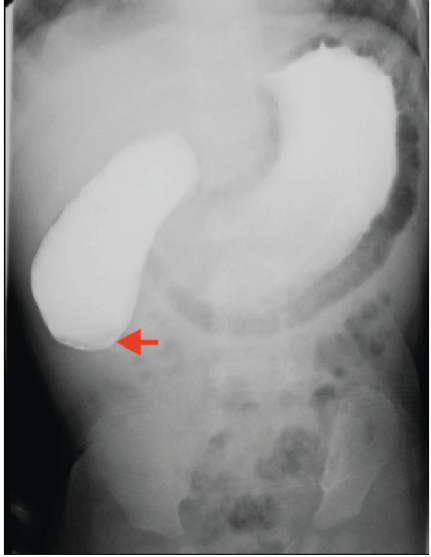
Figure 2: Upper gastrointestinal contrast study revealing complete obstruction at the 2nd part of the duodenum (red